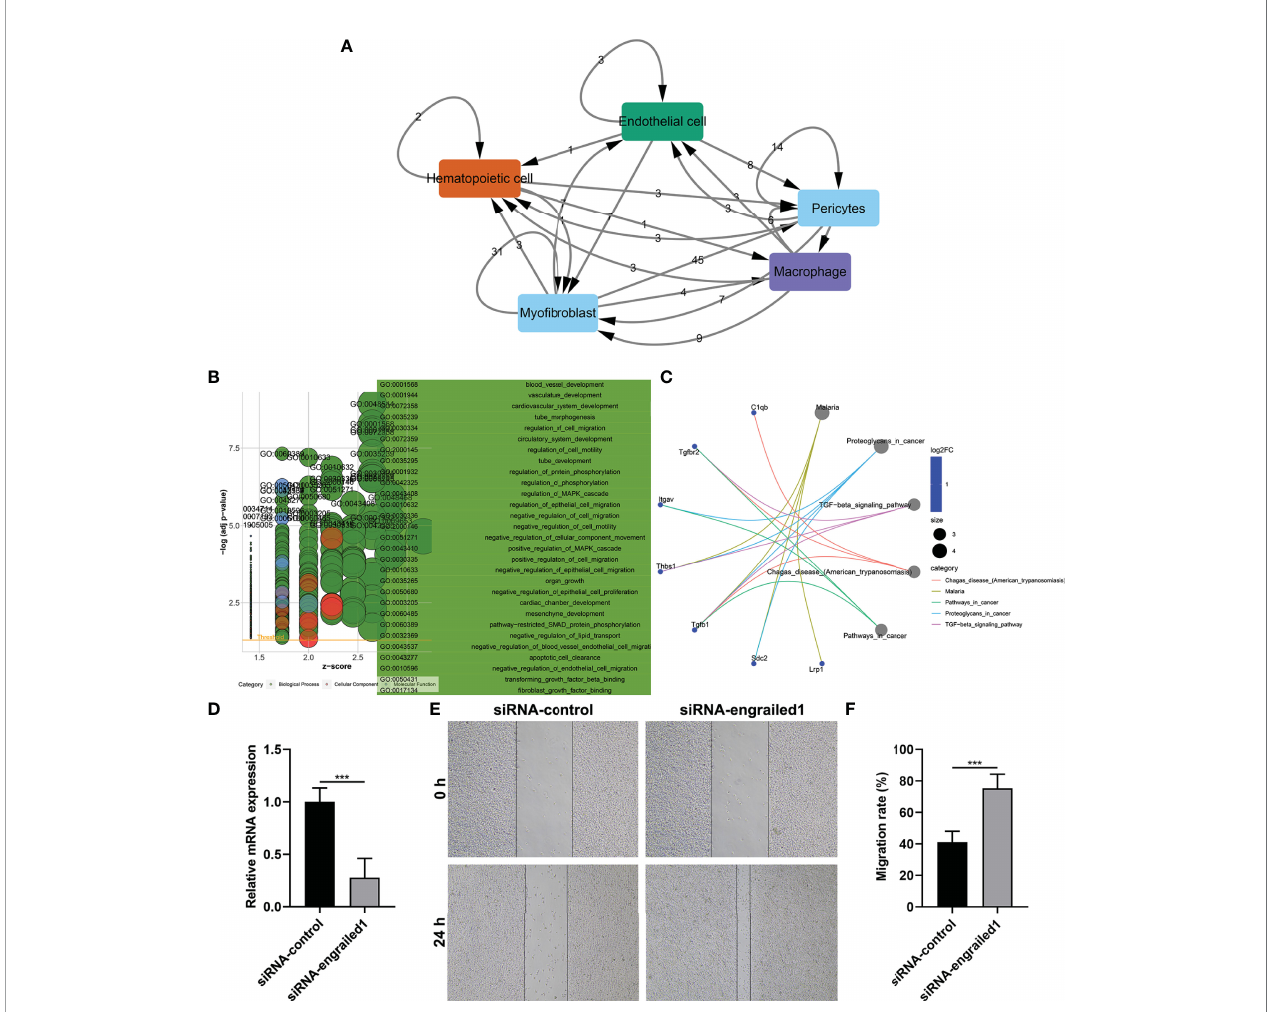
FIGURE 3 | Cell – cell interactions and biological functions of ligand and receptor genes between myo fi broblasts and macrophages. (A) The network of ligand – receptor-mediated multicellular signaling. The arrow pointed to the recipient cell, and the number on the line indicated the number of receptor – ligand pairs. (B) GO enrichment results of ligand and receptor genes between myo fi broblasts and macrophages. (C) KEGG pathways enriched by ligand and receptor genes between myo fi broblasts and macrophages. (D) RT-qPCR for the mRNA expressions of EN1 in fi broblasts transfected with siRNA of EN1. (E, F) Wound healing assay for the migration of EN1-knockdown fi broblasts. Bar, 20 m m. *** p <